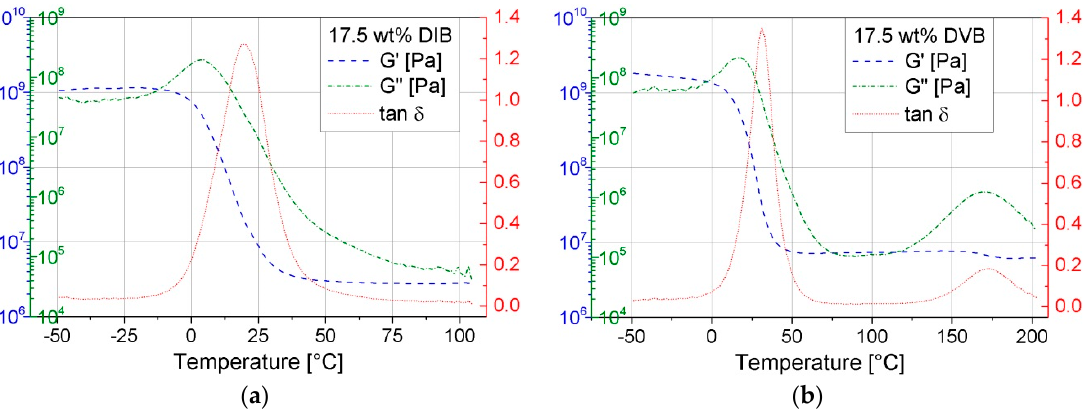
Figure 15. DMA diagrams of sulfur copolymers: ( a ) pS-DIB; ( b ) pS-DVB.